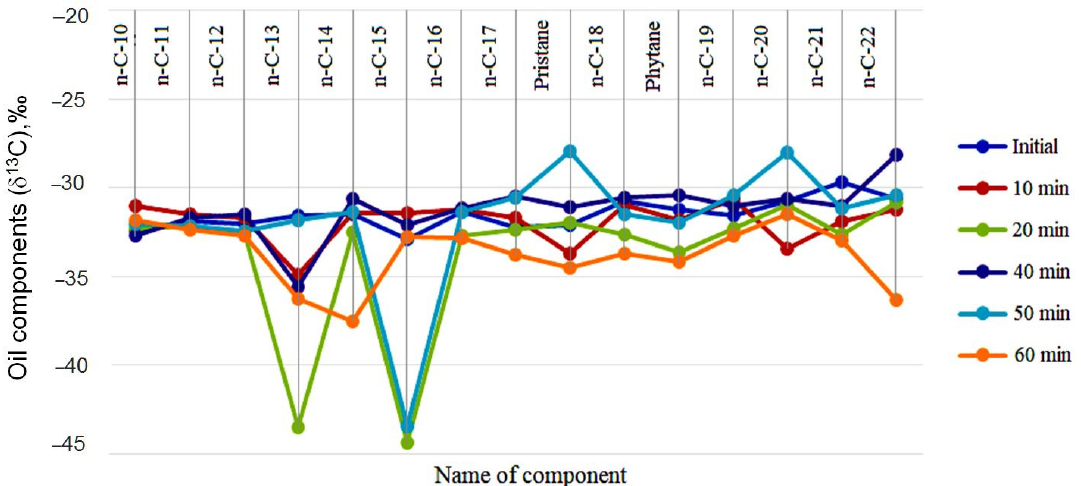
Figure 7. Isotopic ( δ 13 C) changes of sample components.